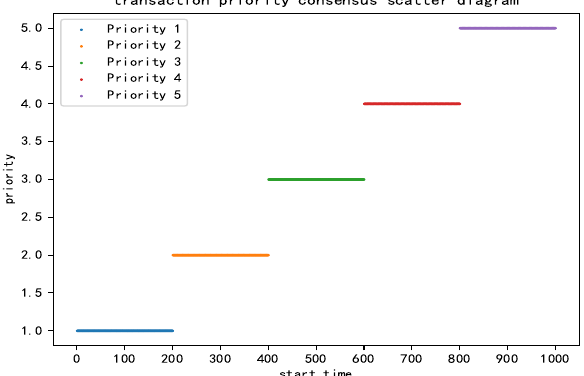
Figure 16. Prioritized transaction scatter